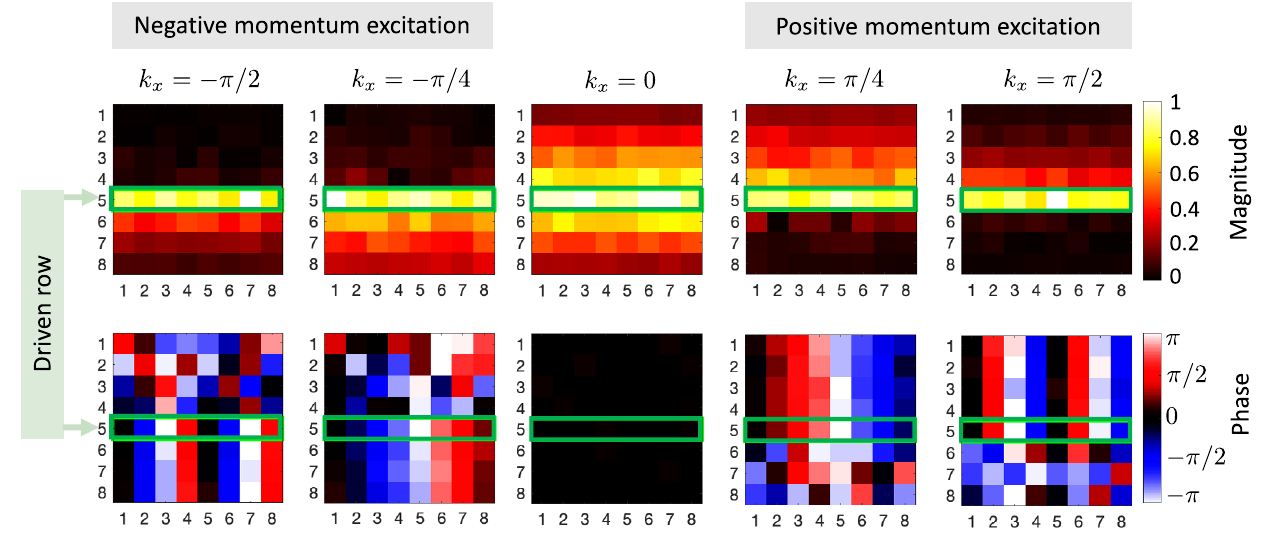
Fig. 4 | Responses to input excitations for the cylinder geometry. We apply voltage inputs on the fi fth row (highlighted by the green box) with relative phase corresponding to momentum k x . The speci fi c momentum values are quantized by